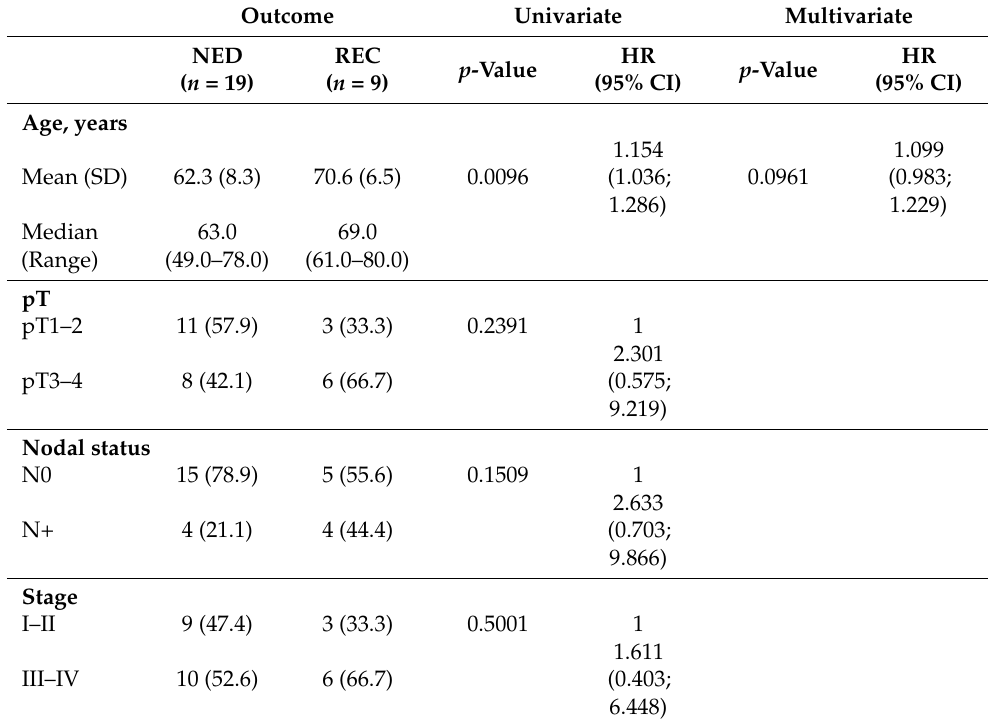
Table 4. Descriptive statistics: univariate and multivariate Cox’s regression results on demographic and clinical-pathological variables within the conventional SCC